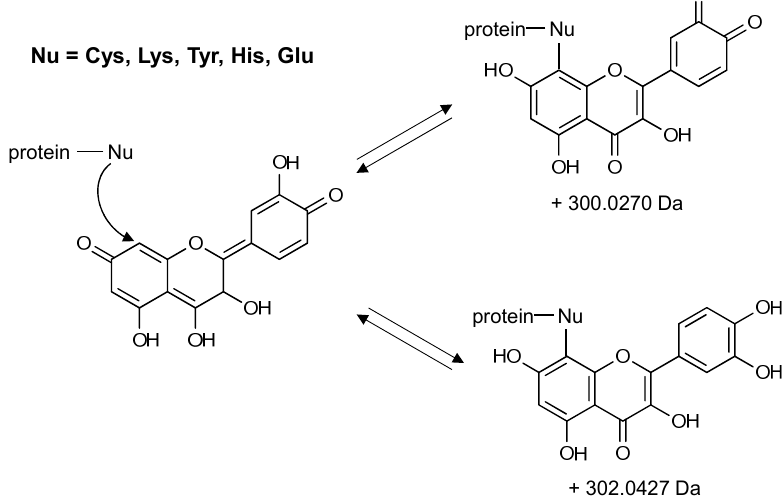
Figure 7. Proposed reaction scheme of nucleophilic protein residues with electrophilic flavonoid quinones. Expected characteristic mass shifts are shown for the quercetin quinone ( top ) and reduced quercetin ( bottom ).